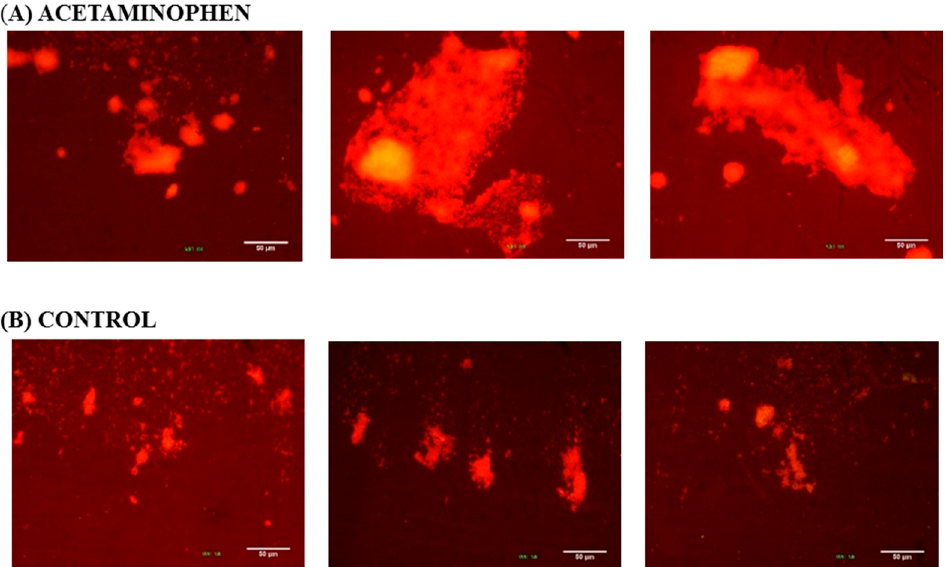
Figure 5. K. pneumoniae ATCC 13884 biofilm formed on coverslip glass. The images were taken from three different zones on the coverslip glass. The brighter areas indicate greater accumulation of bacteria. ( A ) Biofilm assembled under acetaminophen has more bacterial aggrupation and a larger colonized area. ( B ) The control group has few bright areas and less bacteria adherence. Bar 50 µm.